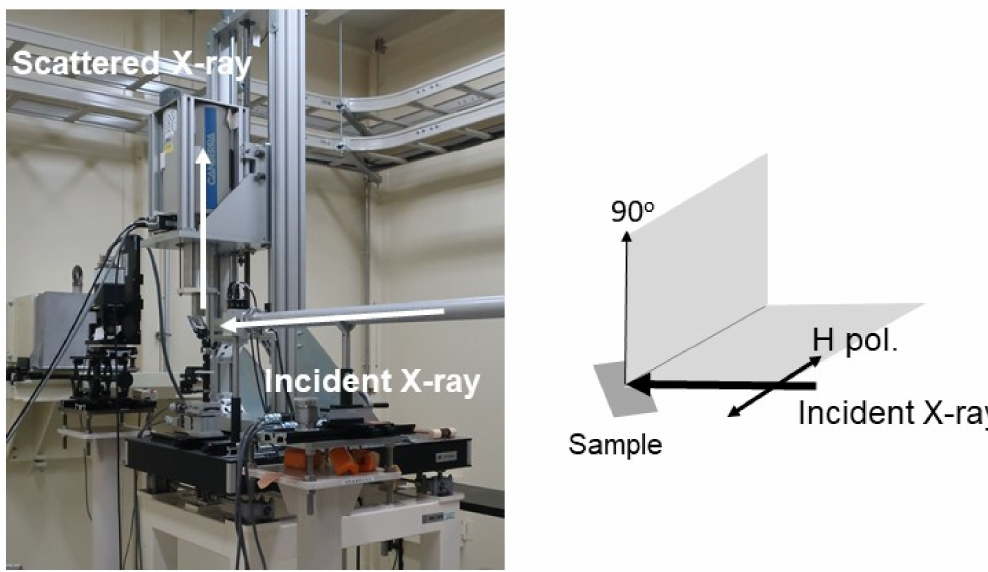
Figure 2. Experimental setup. Incident X-rays (come from the right) with horizontal polarization irradiates a sample. Scattered X-rays are detected with a scattering angle of 90 ◦ . The scattering plane is perpendicular to the linear polarization vector (H. pol.), which is shown as 90 ◦